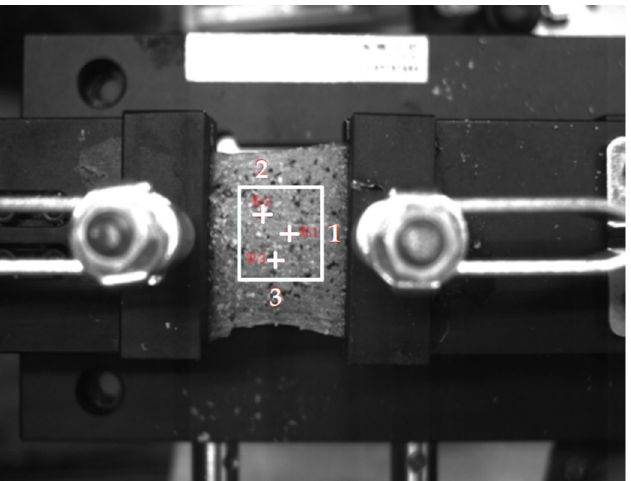
Figure 13. Analysis area of biological tissue. Point 1 is the central area where the laser light passes through; Points 2 and 3 are two random ones in the area.